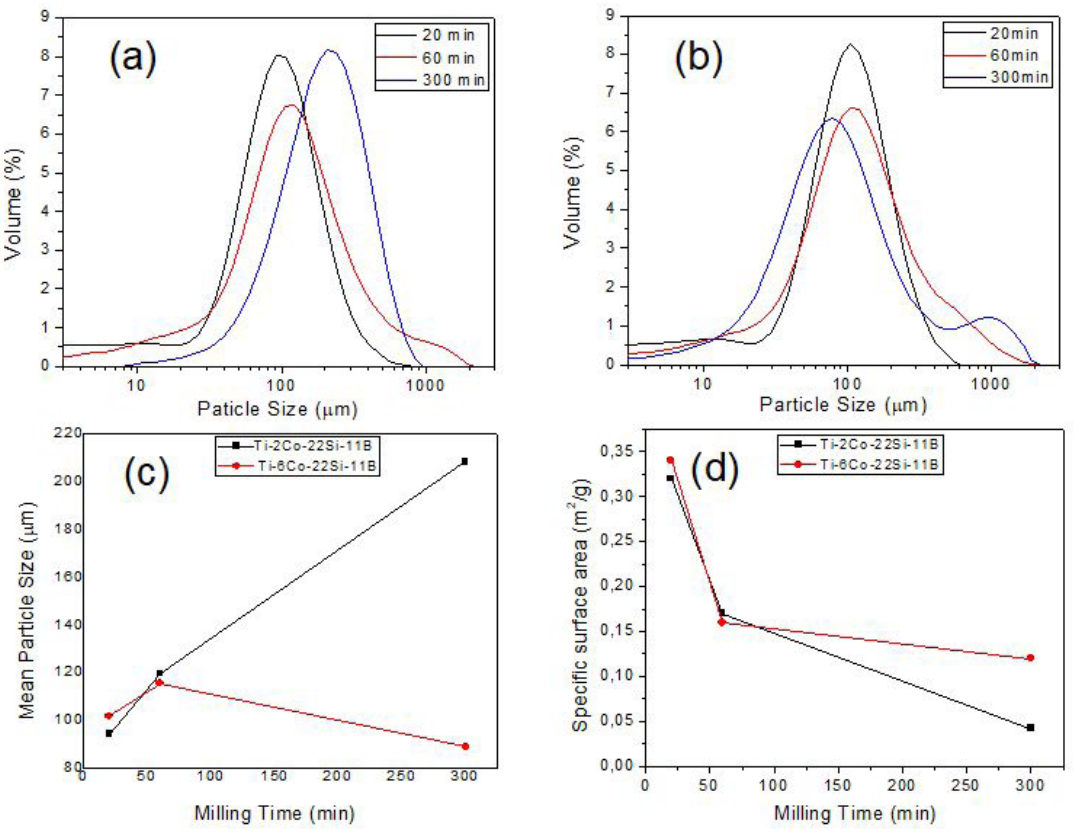
Figure 3. Particle size distribution curves of the (a) Ti-2Co-22Si-11B and (b) Ti-6Co-22Si-11B powder mixtures after different milling times. In (c) and (d), the effect of composition and milling time on the average particle sizes and specific surface areas of the Ti-Co-Si-B powders,